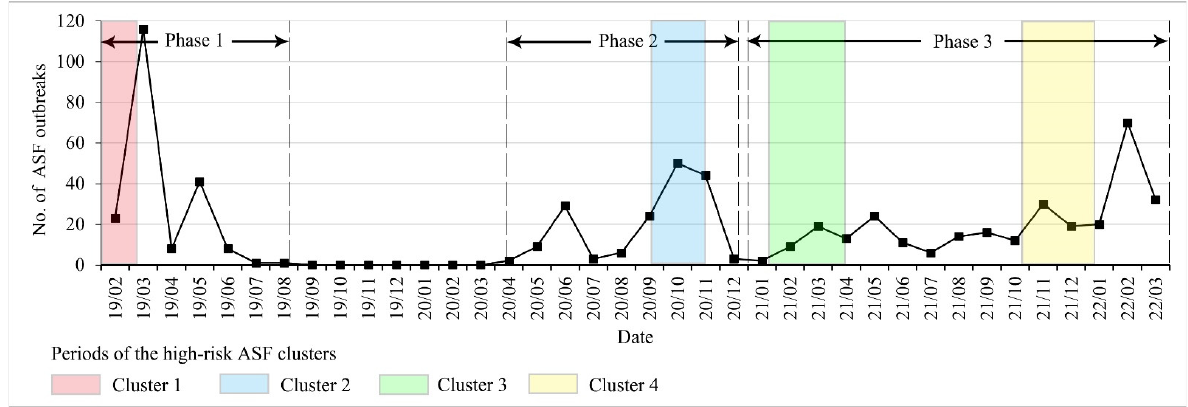
Figure 1. The number of new ASF outbreaks per month in Vietnam (February 2019–March 2022).